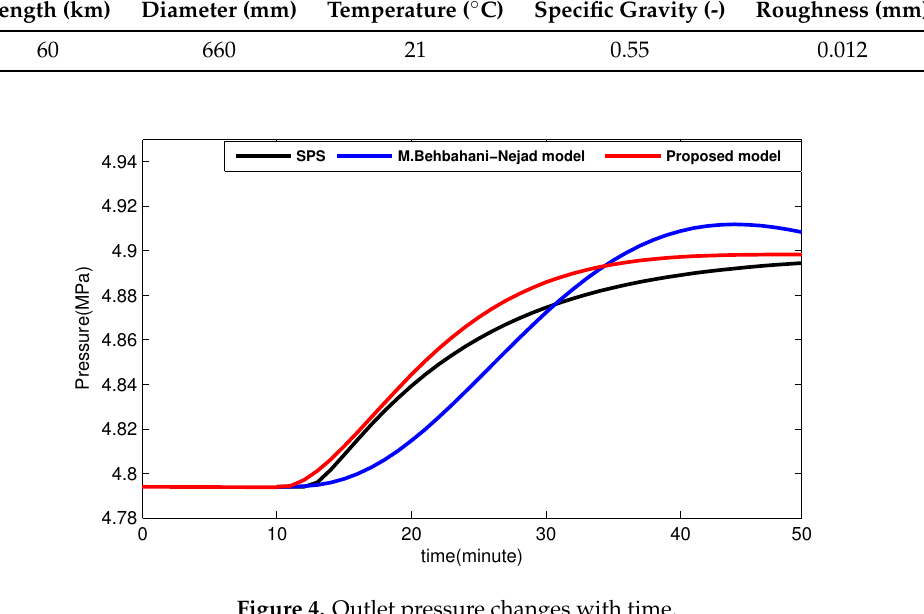
Figure 4. Outlet pressure changes with